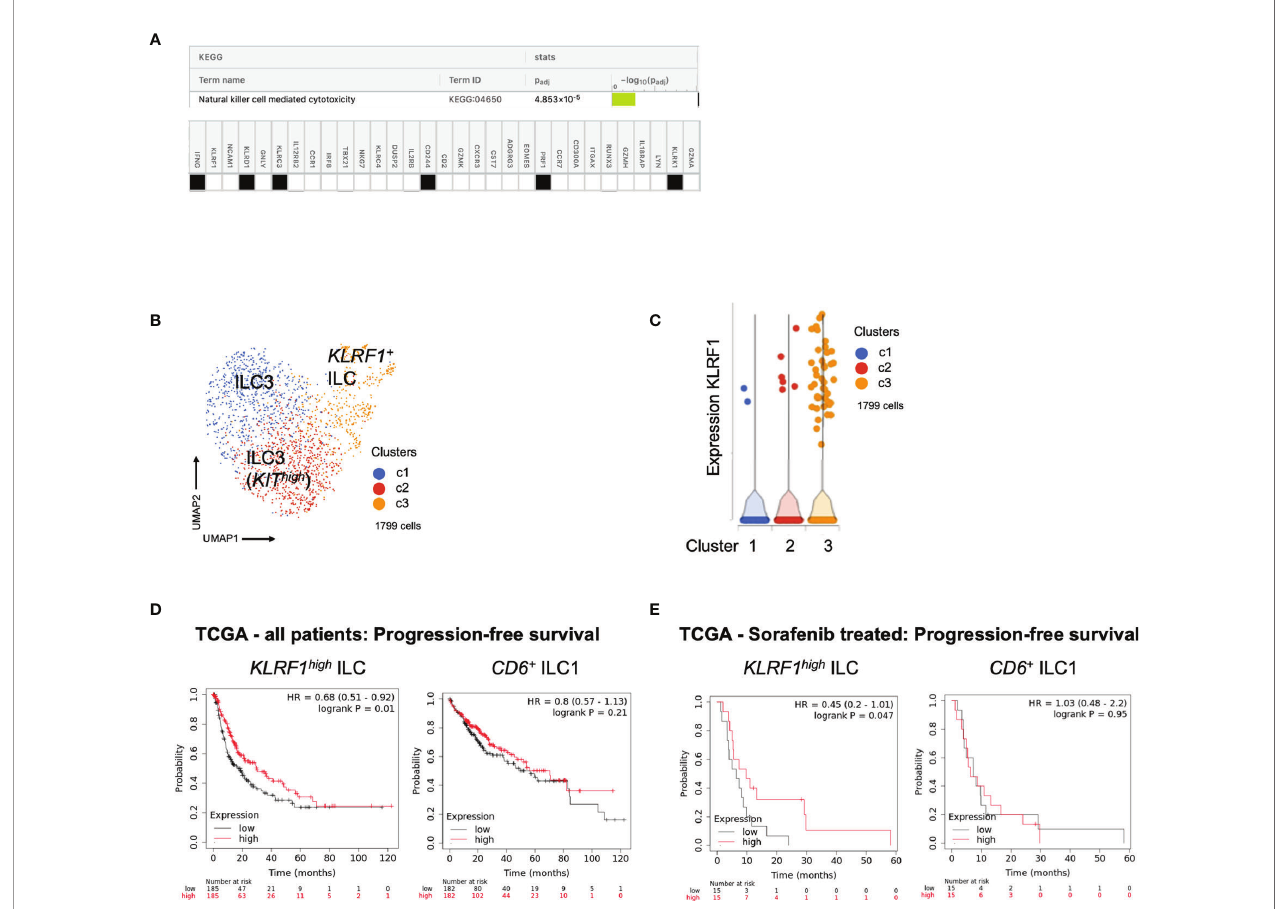
FIGURE 5 | (A) Pathway analysis using signature derived from transcripts of KLRF1 high ILCs in PBMCs. KEGG database analysis using gpro fi ler identi fi es “ Natural killer cell mediated cytotoxicity ” as top upregulated pathway. Table shows genes expressed by KLRF1 high ILCs which are involved in the identi fi ed pathway. (B) UMAP plot of IL7R + KLRB1 + ILCs from liver tissue of patients with HCC. Identi fi cation of 3 main clusters including two ILC3 clusters and one ILC1 cluster. For detailed DEGs see Table S1 . (C) Violin plot showing expression of KLRF1 in clusters identi fi ed in Figure 5B . For detailed DEGs see Table S1 . (D) Analysis of progression-free survival of TCGA liver cancer cohort of patients who have received sorafenib using KaplanMeier-plotter. Survival prediction based on signatures ( Table S1 ) derived from transcripts of KLRF1 high ILCs or CD6 + ILC1s in PBMCs. Table showing risk strati fi cation of patients. (E) Analysis of progression-free survival of TCGA liver cancer cohort of patients who have received sorafenib using Kaplan Meier-plotter. Survival prediction based on signatures derived from transcripts of KLRF1 high ILCs or CD6 + ILC1s in PBMCs. Table showing risk strati fi cation of